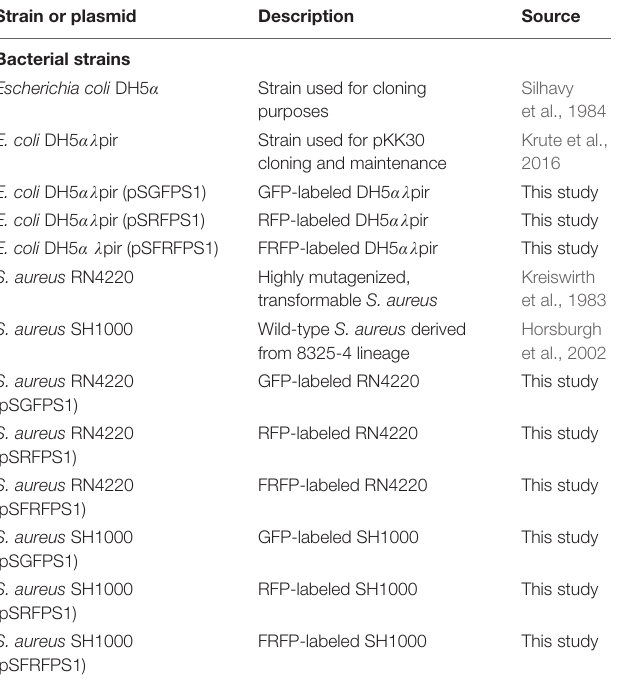
TABLE 1 | Bacterial strains and plasmids used in this